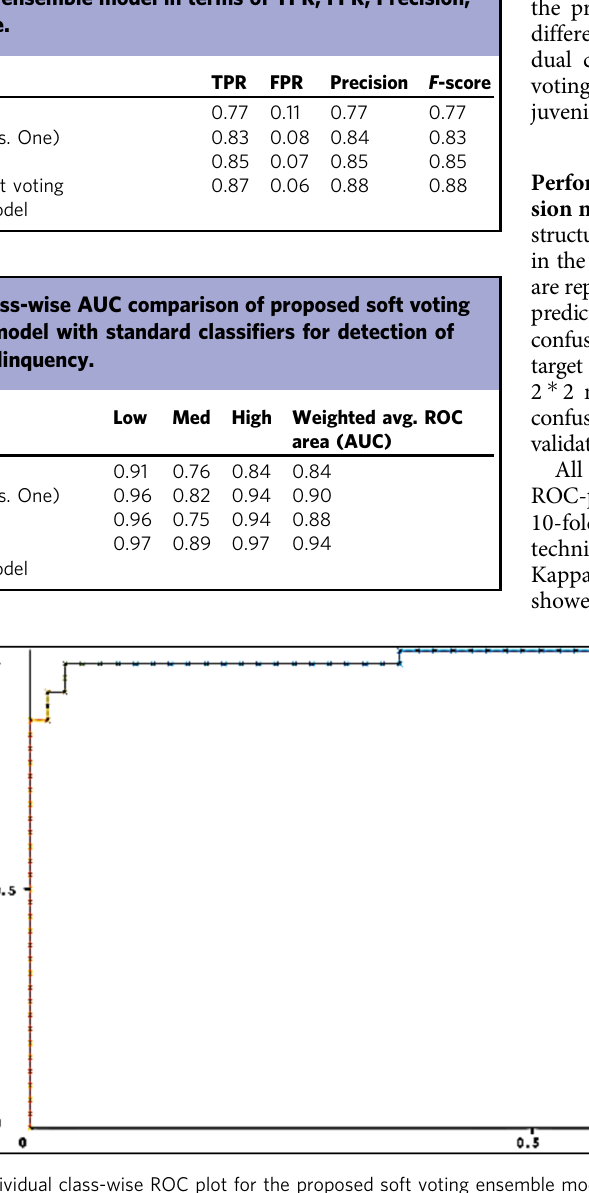
Fig. 7 The individual class-wise ROC plot for the proposed soft voting ensemble model showing the classi fi cation performance for class ‘ Low ’